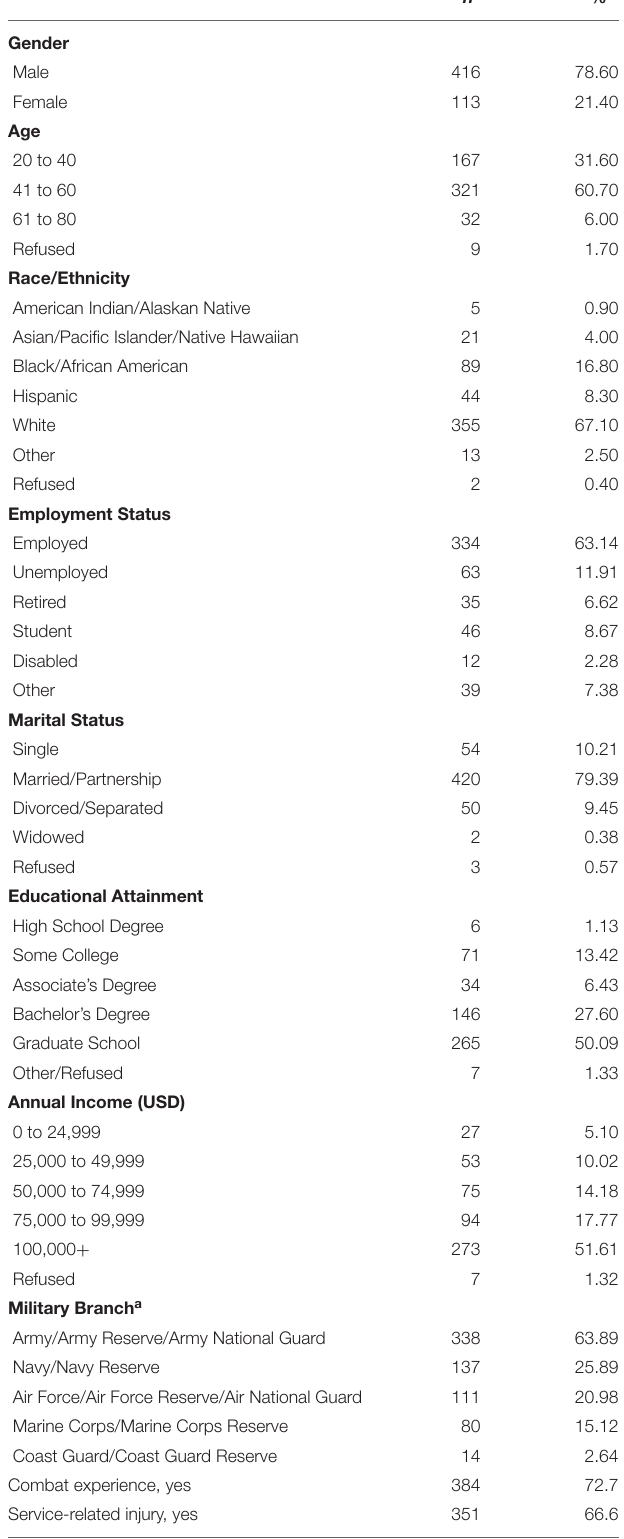
TABLE 1 | Demographic characteristics of the study sample ( n =